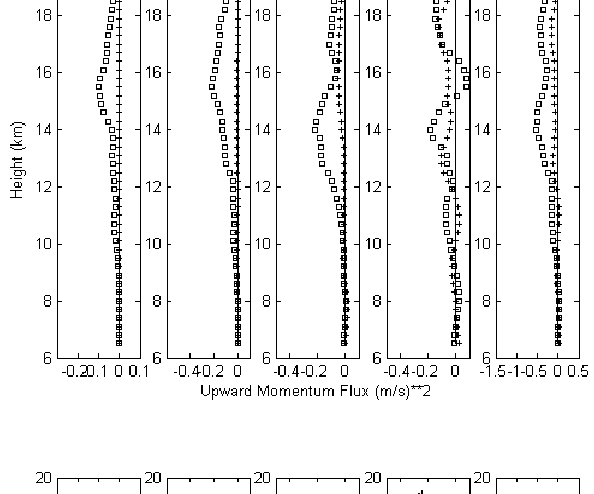
Table 1. The 72h average upward flux and downward flux of zonal momentum in the height 6 ∼ 19km for different wave period bands.